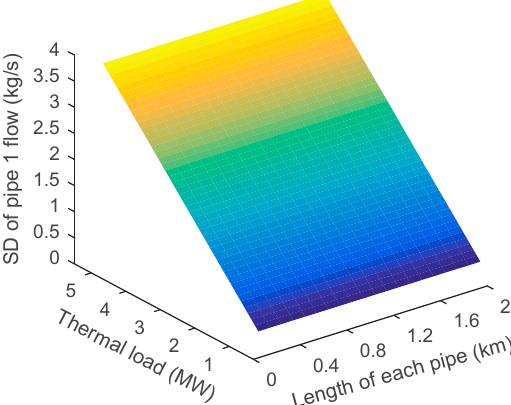
Figure 8. Relationship between the standard deviation of mass flow rate for pipe 1 with respect to pipe length and mean thermal load (Test 4: σ ϕ = ±10%).